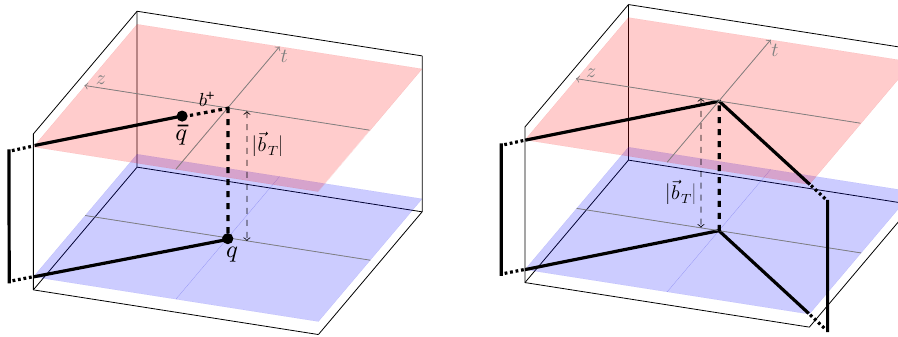
Figure 1. Graphs of the Wilson line structure of the n -collinear beam function B q (left) and the soft function S q (right), de(cid:12)ned in eqs. (2.5) and (2.6). The Wilson lines (solid) extend to in(cid:12)nity in the directions indicated. Adapted from ref.